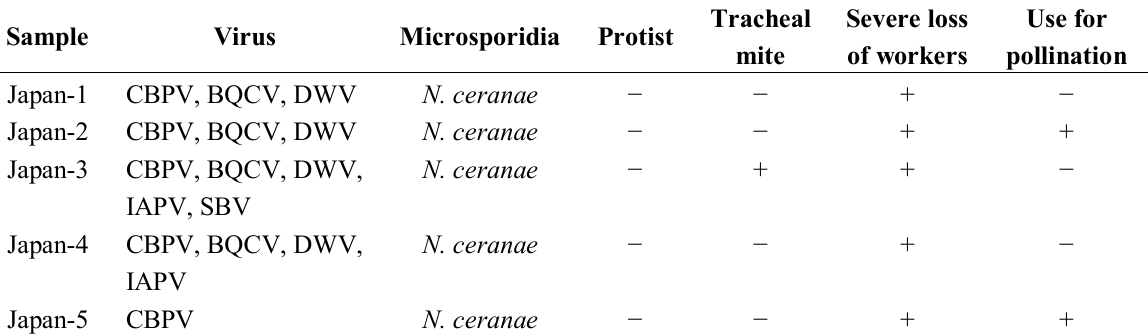
Table 1. Summary of pathogens and parasite present in CBPV-infected A. mellifera colonies. Sample Virus Microsporidia Protist